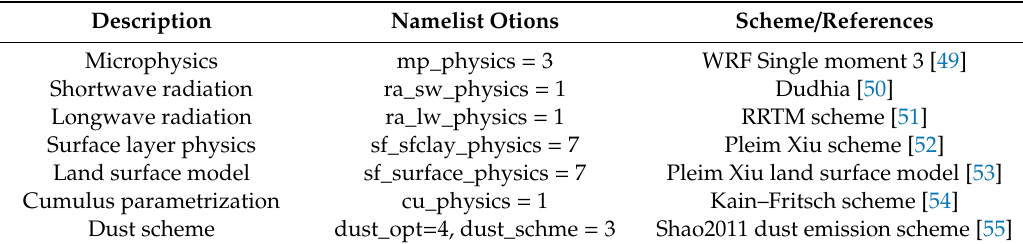
Table 1. Physical and chemical configuration of WRF-CHEM.